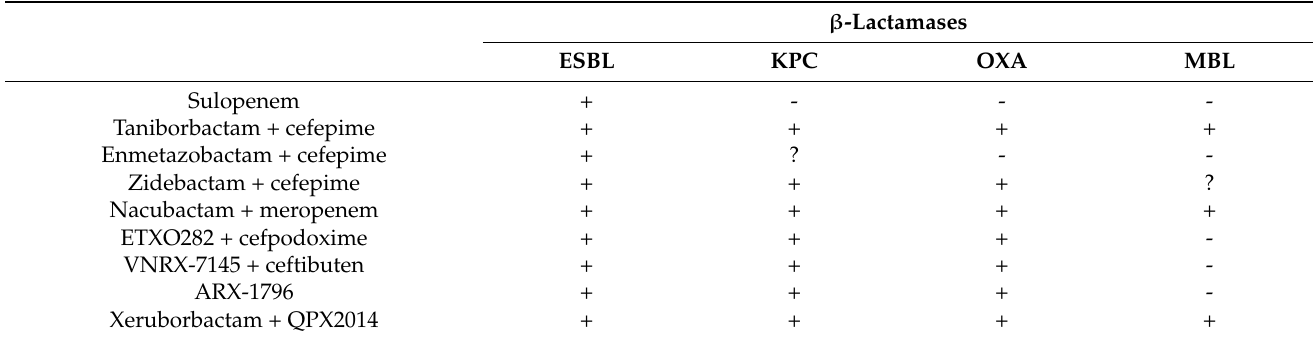
Table 2. Expected activity of novel β -lactams and β -lactam- β -lactamase combinations against com- mon β -lactamases